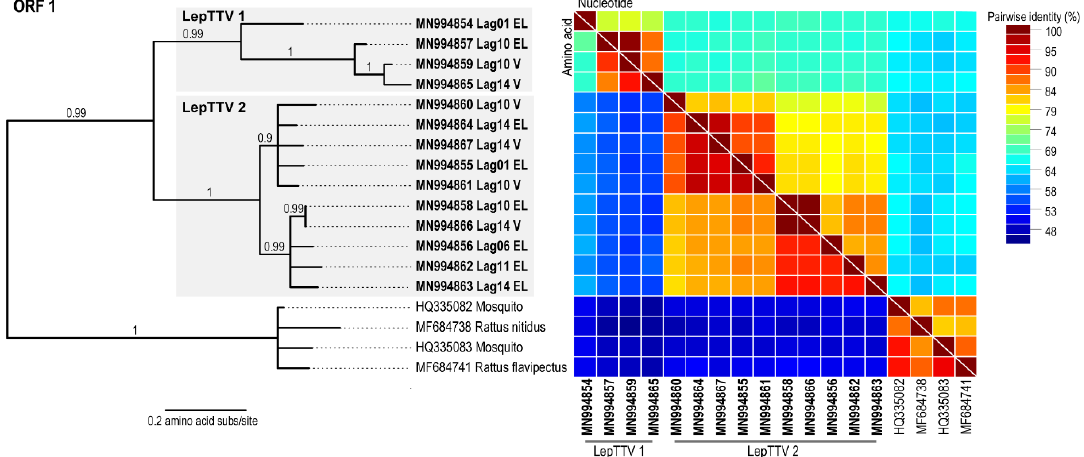
Figure 2. Maximum likelihood phylogenetic tree of the anelloviruses ORF1 protein sequences of those recovered from hares together with those most closely related, available in GenBank. A pairwise comparison color matrix of the ORF1 amino acid and nucleotide sequence is shown to the right of the phylogenetic tree.